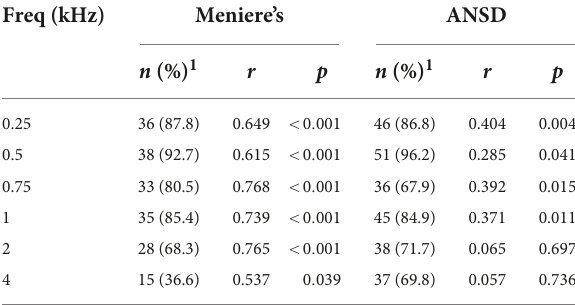
TABLE 1 Relationships between the summating potential (SP) and alternating current (AC) response